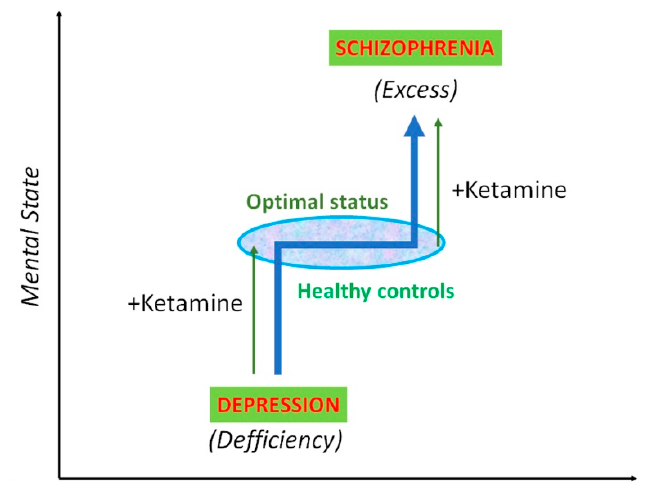
Figure 4. Schematic representation of mental state that appears as a continuum that can be modulated by ketamine. Ketamine can alleviate depressive symptoms in patients, but also induce psychotic symptoms when administered to healthy subjects. The terms deficiency and excess are abstract concepts herein, but can refer, for instance, to cortical monoamine levels.